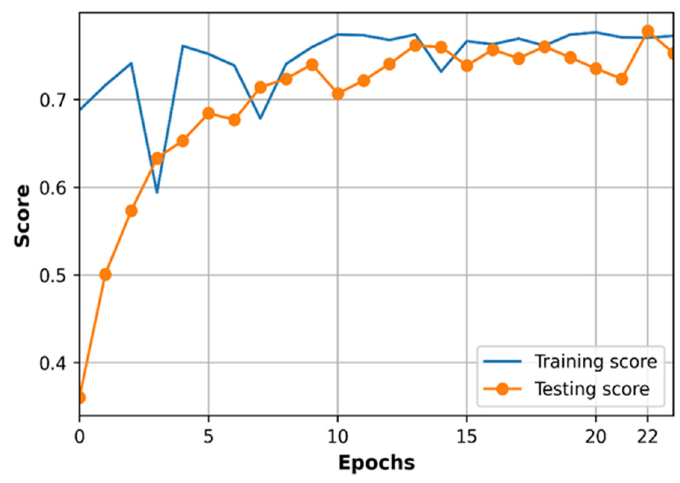
Figure 9. Accuracy of training and testing datasets according to epochs.